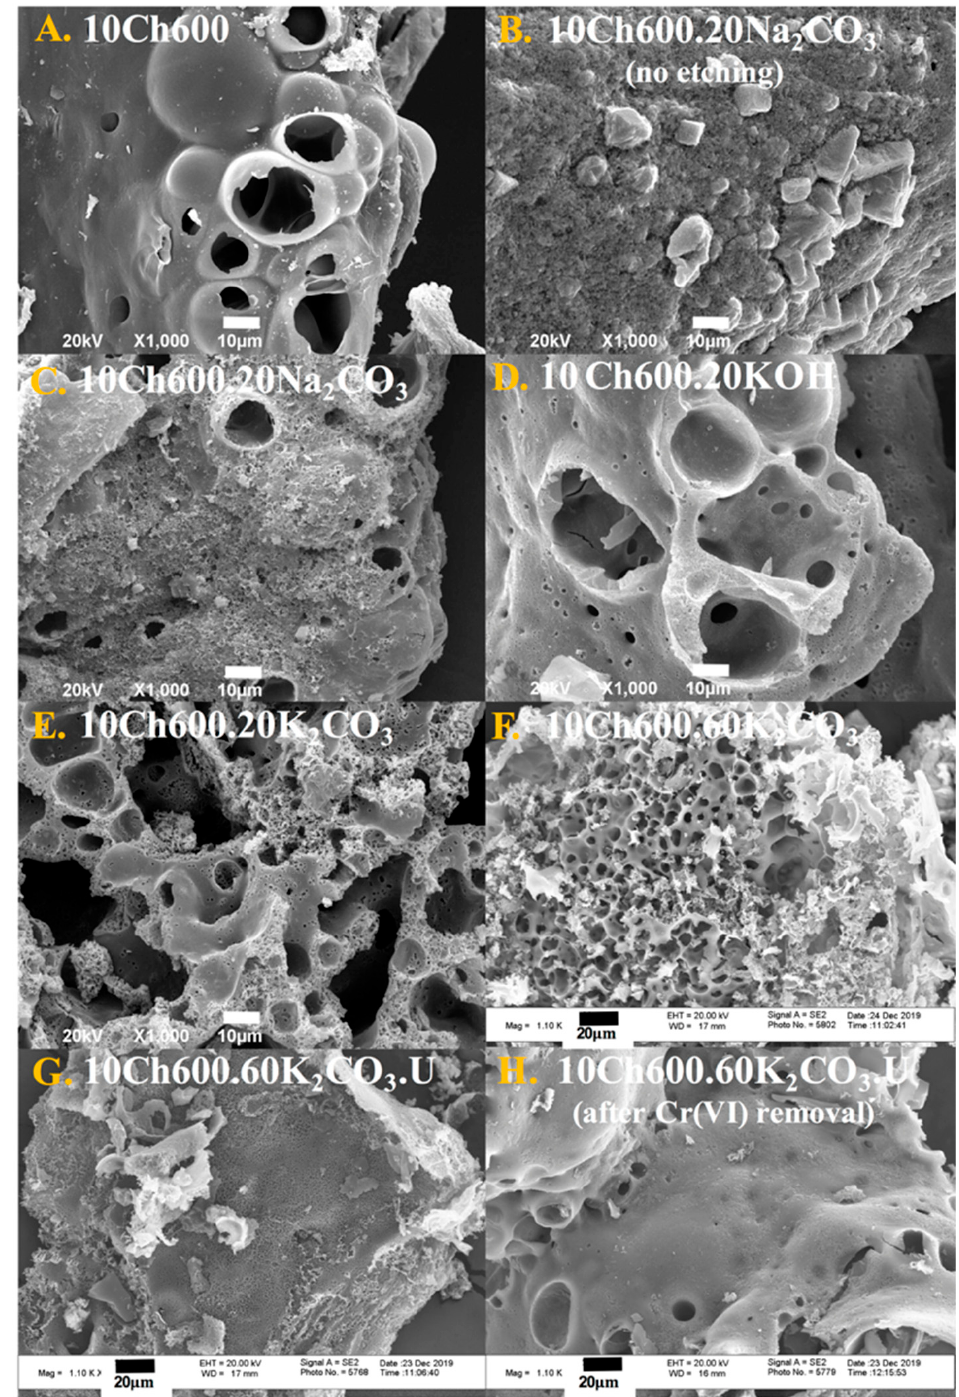
Figure 2. SEM ( A – E ) and FESEM ( F – H ) micrographs of AC samples, as